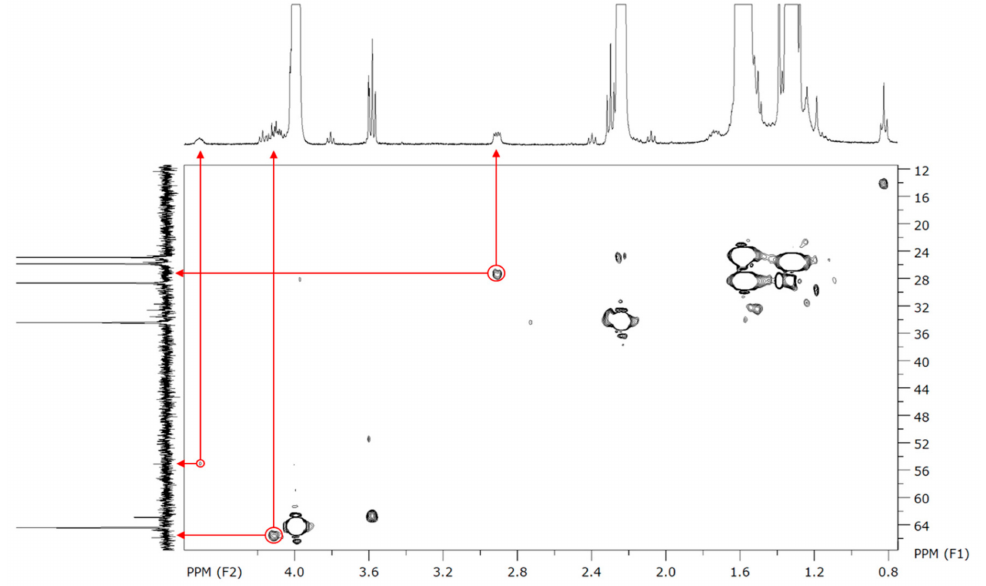
Figure 5. HSQC ( 1 H– 13 C) 2D NMR of polymerization product between CL and 10 mol % of N -Boc Cysteine